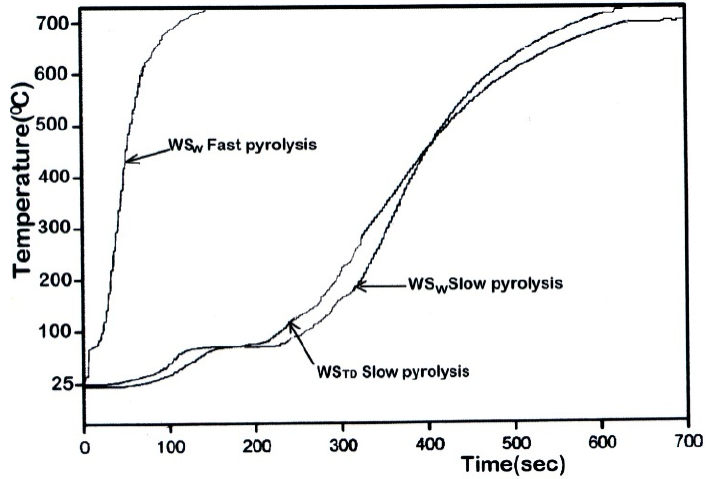
Figure 7. Temperature curves of different walnut shell (WS) samples during pyrolysis tests using the two types of reactors.